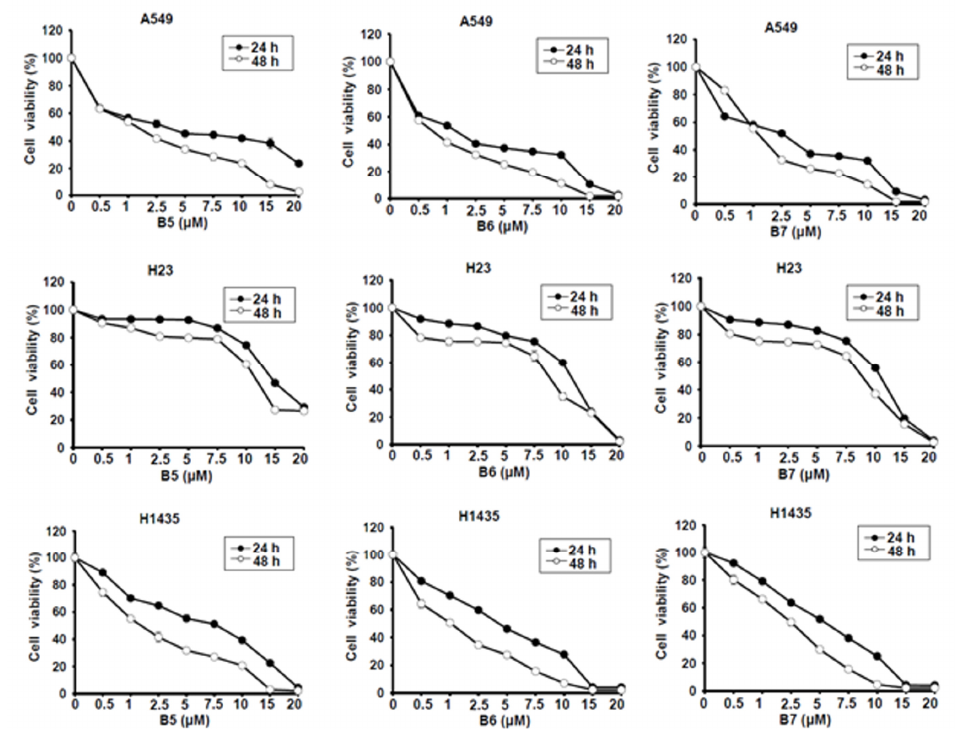
Figure 2. Cellular survival of berberine (B1), berberrubine (B2) and its derivatives B3–B7 in human non-small-cell lung cancer cells. Human non-small-cell lung cancer cell lines, A549, H23 and H1435, were incubated with control medium or various compounds with indicated dosages and the cellular viability was examined at 24 h and 48 h. Table 1. The IC 50 of berberine and its derivatives in human non-small-cell lung cancer cells. Cell Time